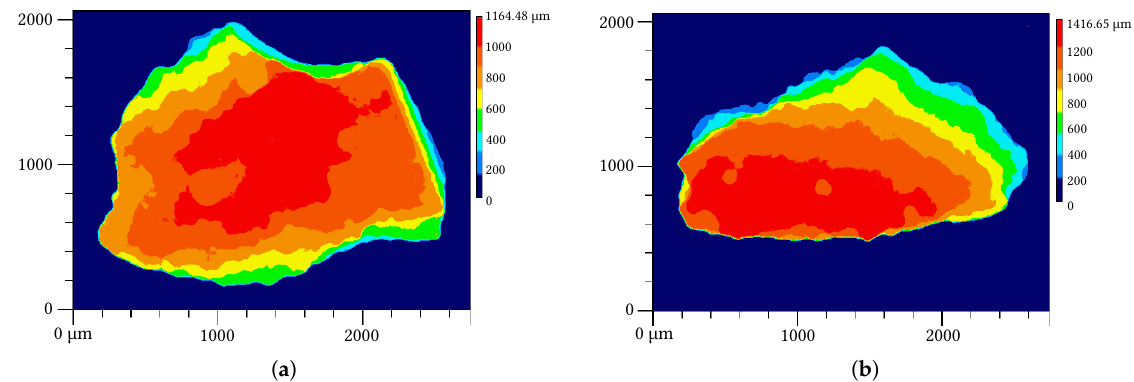
Figure 4. Height maps of particles from the aggregate fraction 1000–3150µm determined with laser-scanning microscopy showing two types of plate-like particle morphologies: ( a ) relatively flat surface plane and ( b ) a more or less pronounced maximum in the vertical